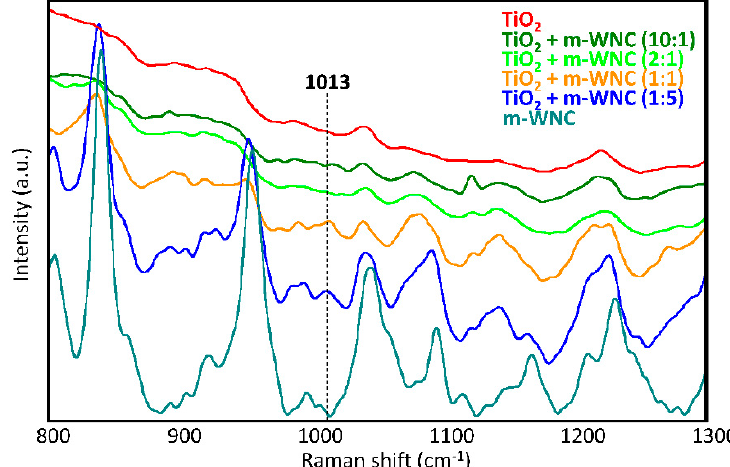
Figure 4. Raman spectra of dry nTiO 2 -W/m-WNC mixtures at different weight ratios: pure TiO 2 , 10:1, 2:1, 1:1, 1:5 and pure m-WNC.